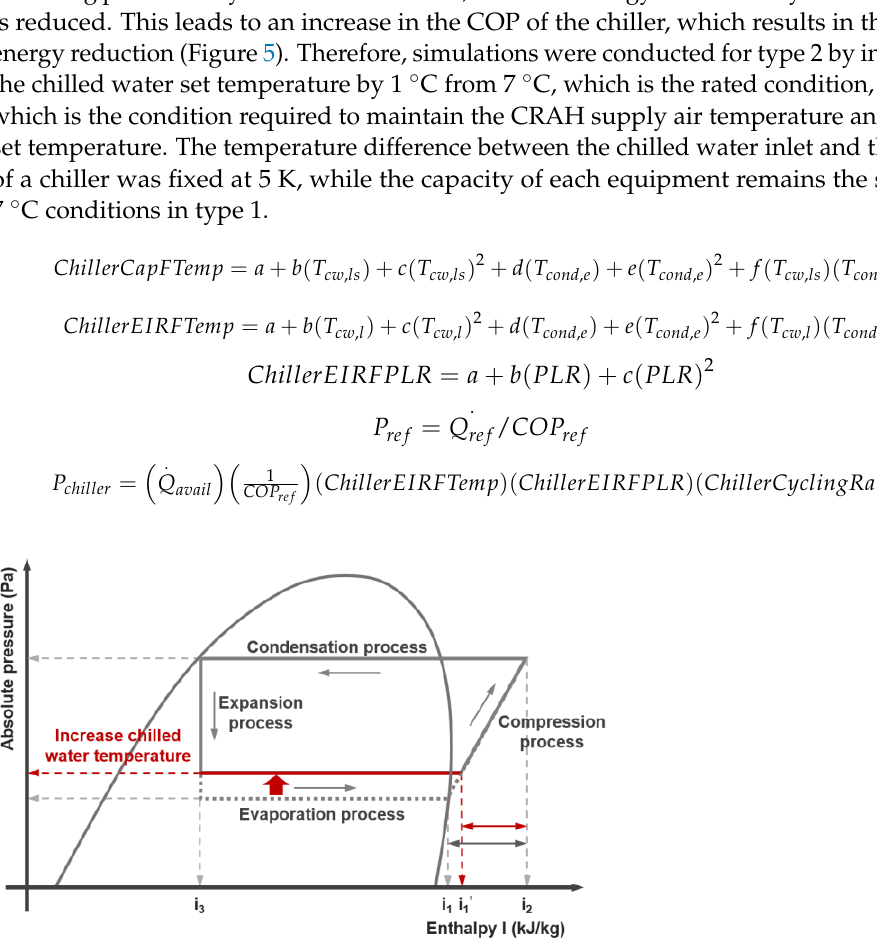
Figure 5. Mollier diagram with increasing chilled water supply temperature.